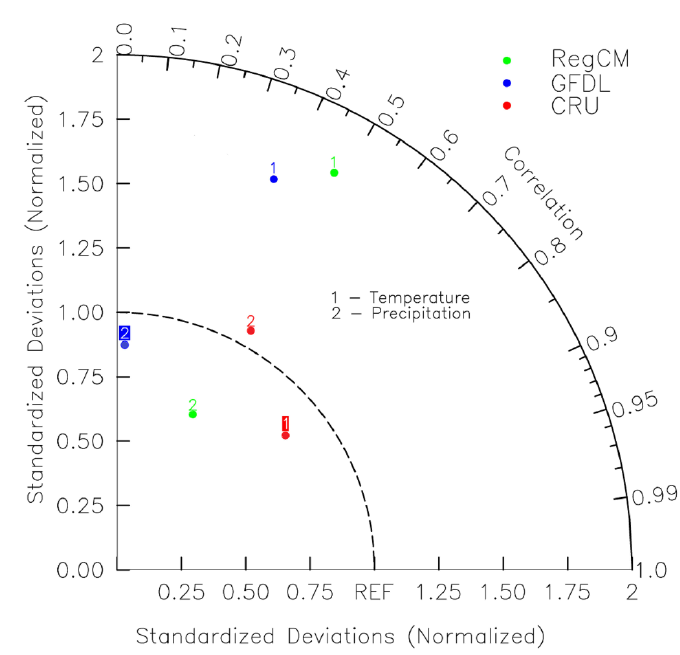
Figure 4. Temperature (°C) and precipitation (mm/day) Taylor diagram for JJAS season over the MCR, compute for land point only for the reference period 1976–2005. The APHRODITE dataset is considered as REF point.